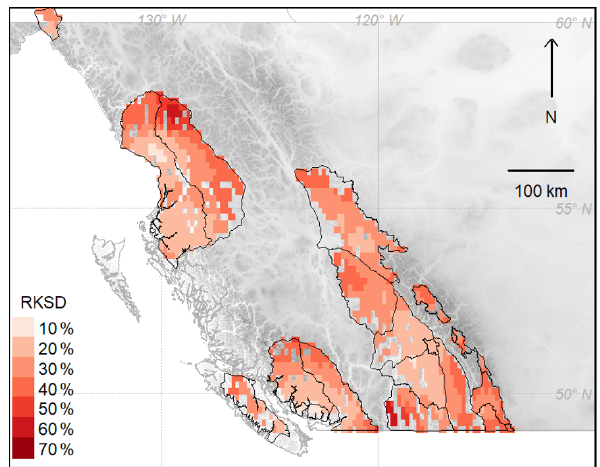
Figure 3. The average relative kriging standard deviation (RKSD) over the study period shows areas with relatively high or low confi- dence in upscaling observed snow depths to regional